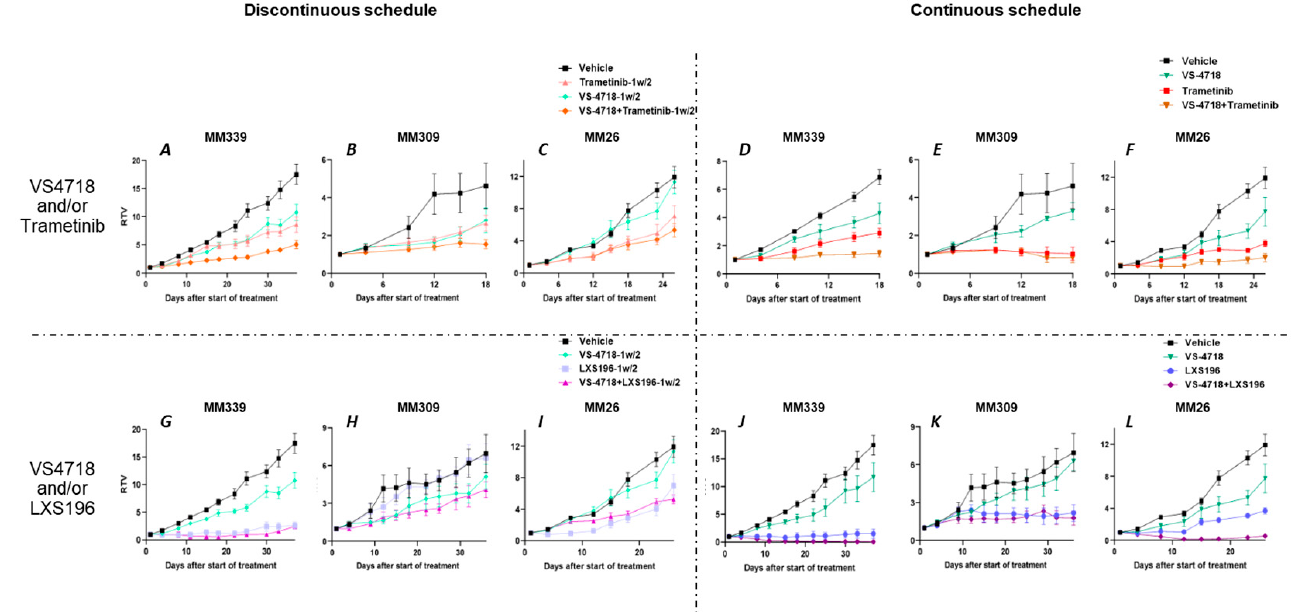
Figure 4. In vivo efficacy assessment: VS4718 combined with Trametinib or LXS196. In vivo efficacy of VS4718 combined with Trametinib ( A – F ) or LXS196 ( G – L ) in three uveal melanoma patient- derived xenografts according to two schedules of treatment, discontinuous (1/2w) [ A – C and G – I ] and continuous treatment [ D – F and J – L ]. RTV: relative tumor volume. Mann-Whitney test is applied to evaluate significance.